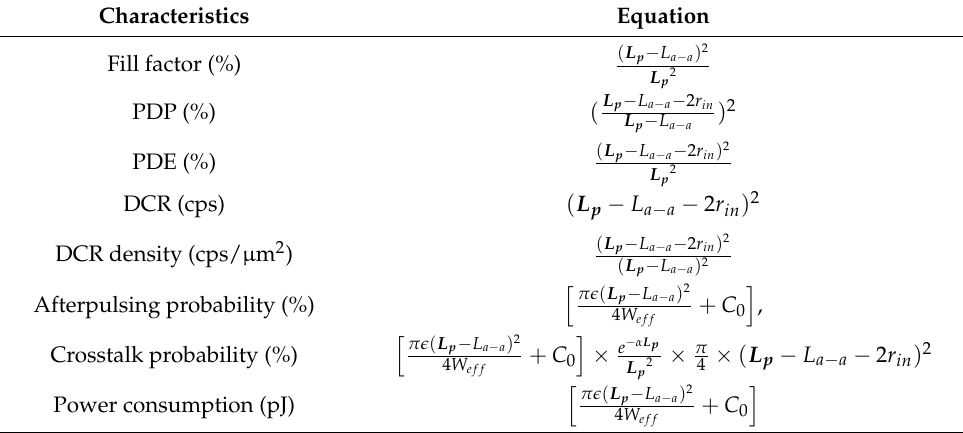
Table 1. Summary of the scaling laws in the SPAD pixels with the pixel pitch L p as a scaling parameter. The coefficient is omitted in the